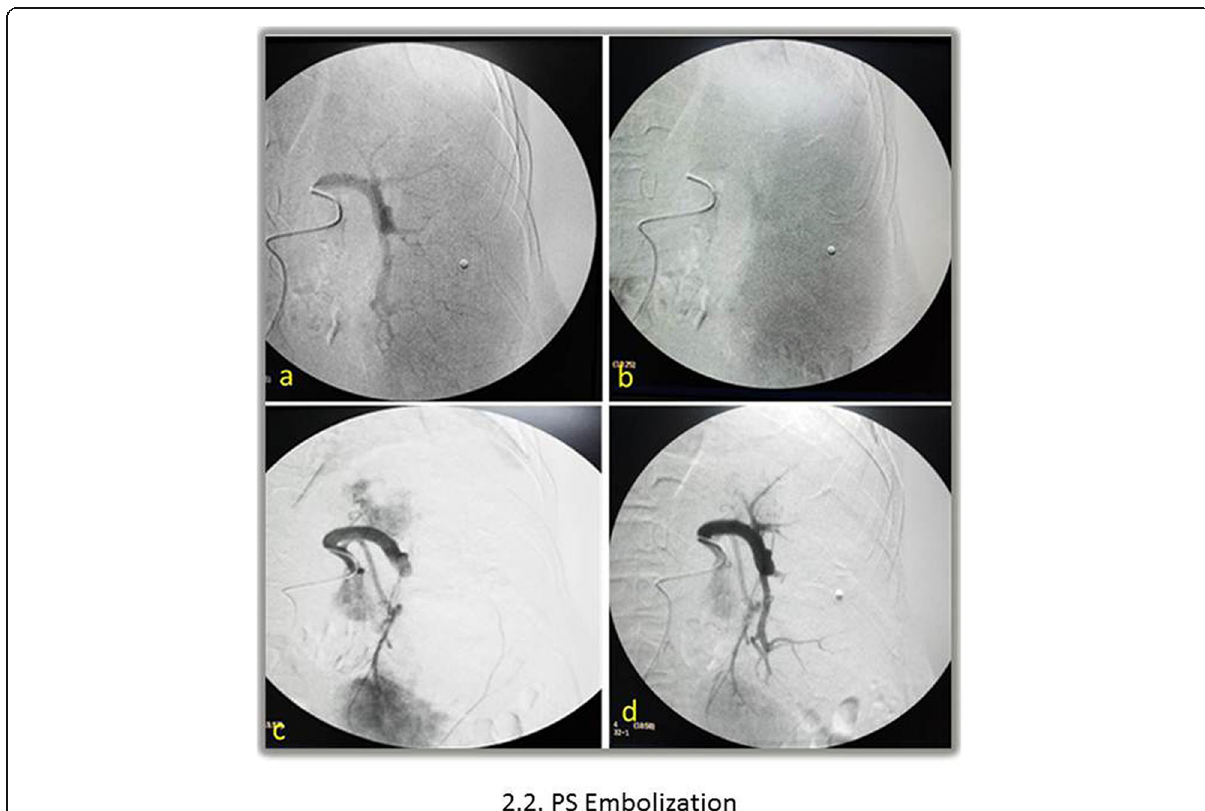
Fig. 3 PSE. DSA pre- and post-embolization. a , b Selective DSA of splenic artery before embolization showing enlarged spleen with diffuse homogeneous contrast enhancement of splenic parenchyma. c , d Digital subtraction splenic angiography post-embolization showing areas of splenic infarctions about (70%) with sparing of areas near the splenic